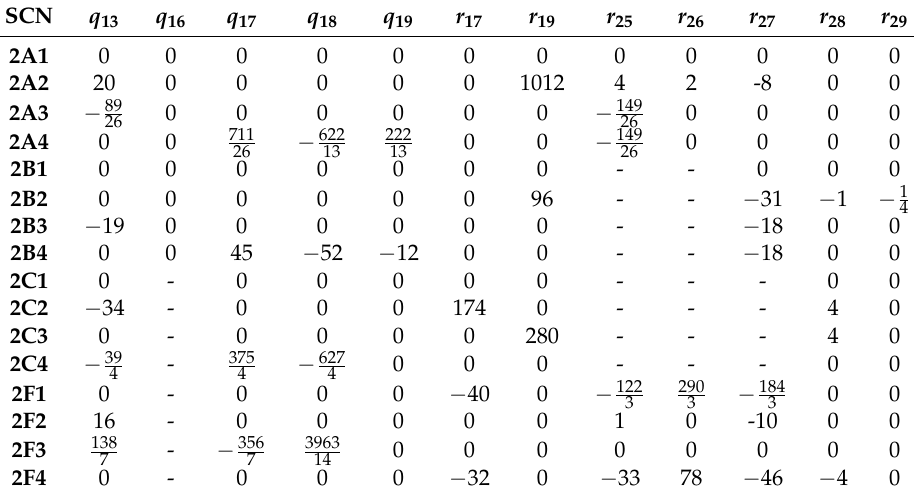
Table 1. Free parameters selected for typical subcases of